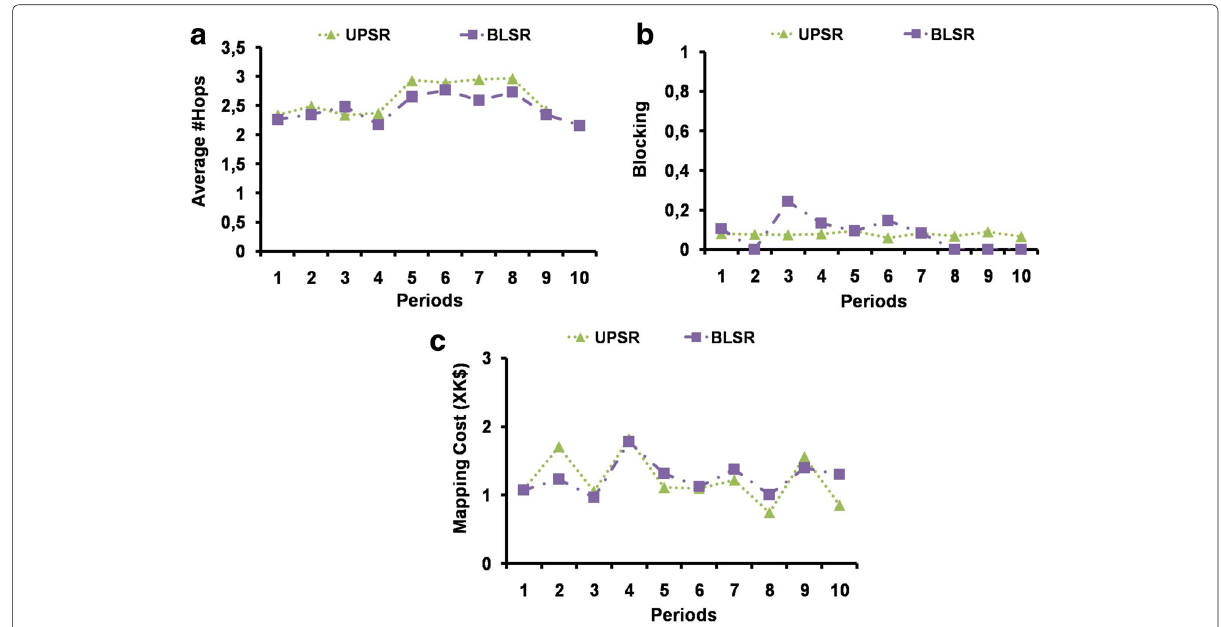
Fig. 9 Performance UPSR vs. BLSR topologies. a Number of Hops. b Blocking ratio. c Mapping